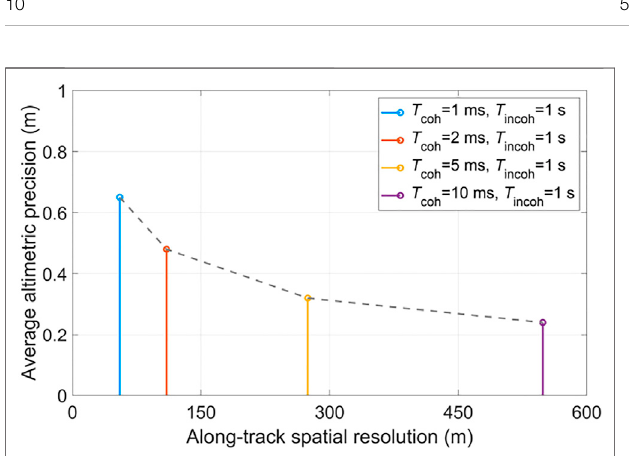
Frontiers in Earth Science |